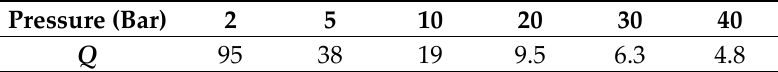
Table 1. Q factor versus absolute pressure from Equation (2).